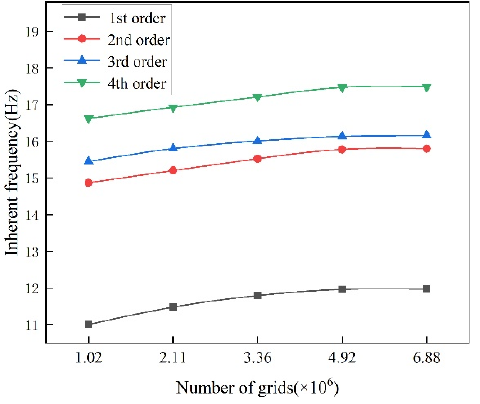
Figure 4. Grid ‐ independent verification of rotor systems. Figure 4. Grid-independent verification of rotor